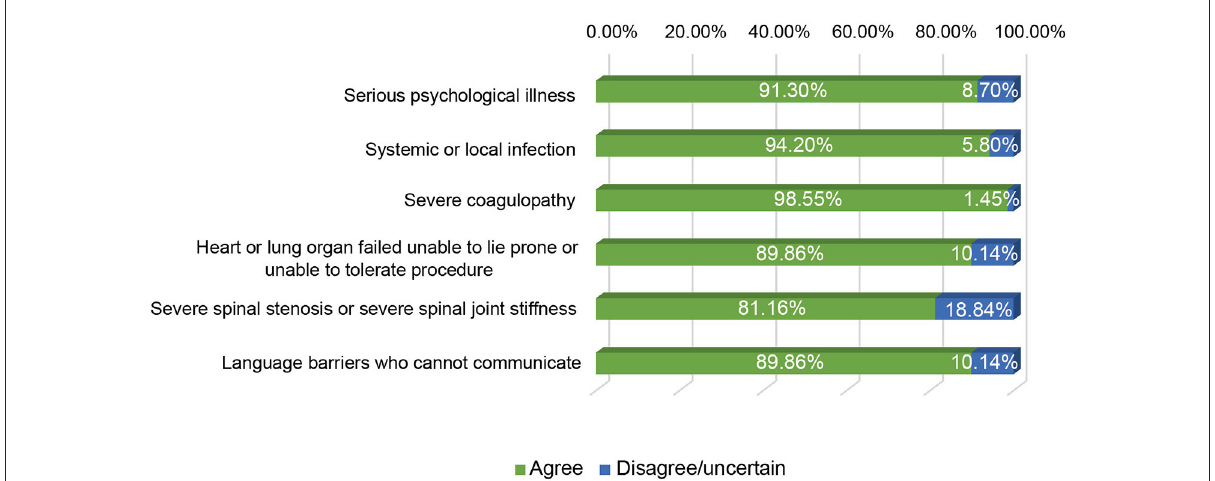
FIGURE6 The contraindication of st-SCS for HN. More than 80% of experts agreed that the HN patients were contraindication for the procedure of st-SCS, who have the following situations of serious psychological illness, systemic or local infection, severe coagulopathy, heart, or lung organ failed unable to lie prone, or unable to tolerate the procedure, severe spinal stenosis, or severe spinal joint stiffness, language barriers who cannot communicate.